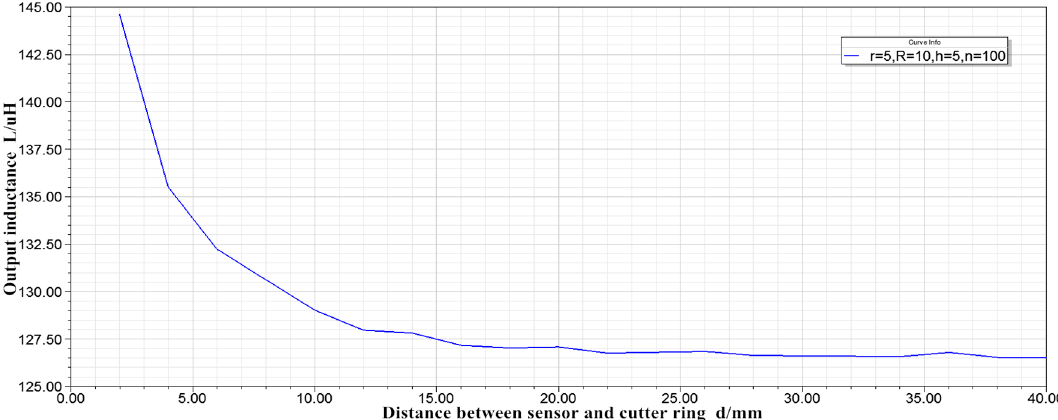
Figure 6. Characteristic curve of inductance displacement.